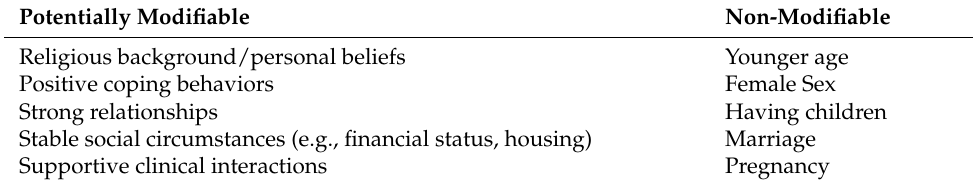
Table 3. Protective factors for